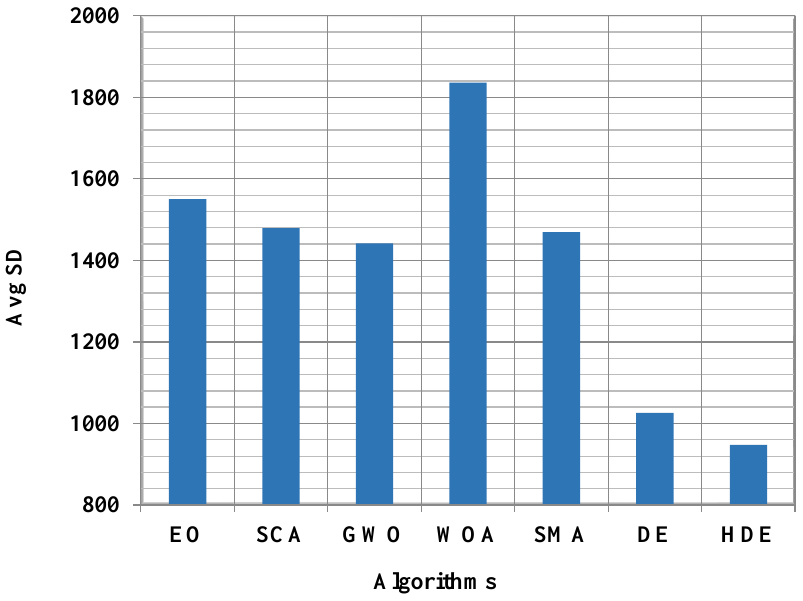
Figure 5. Comparison in terms of average SD of the fitness values.